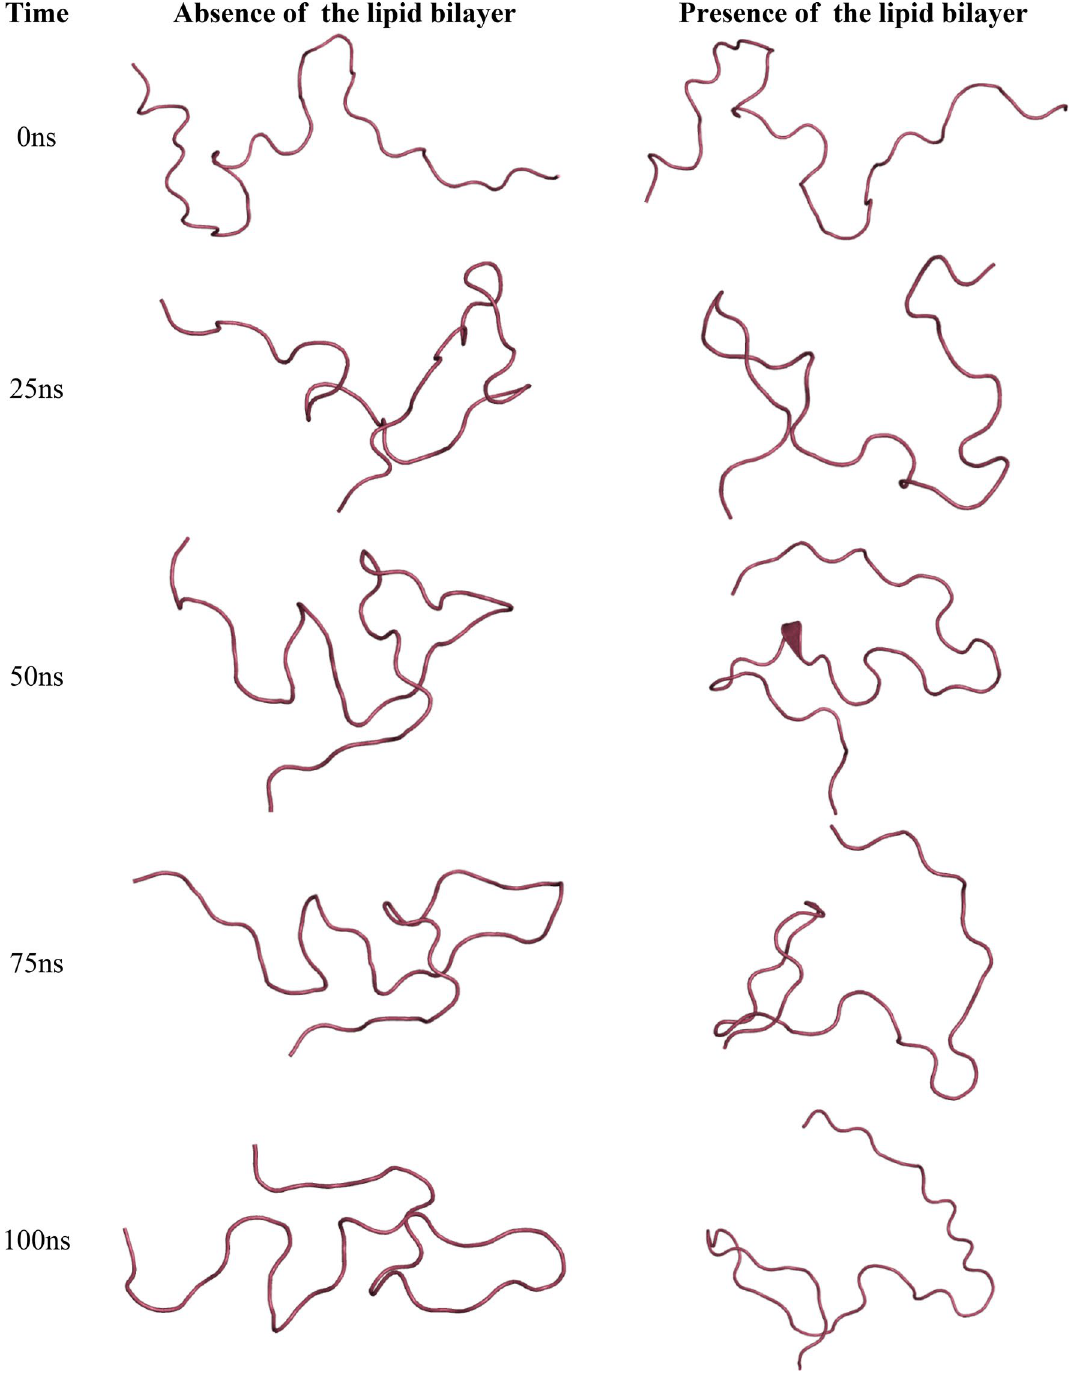
Figure 8. Simulation time-based progression of SSTR2 N-terminal domains in the presence or absence of the lipid bilayer. Figure generated using PyMOL 1.3 (http:// www. pymol.